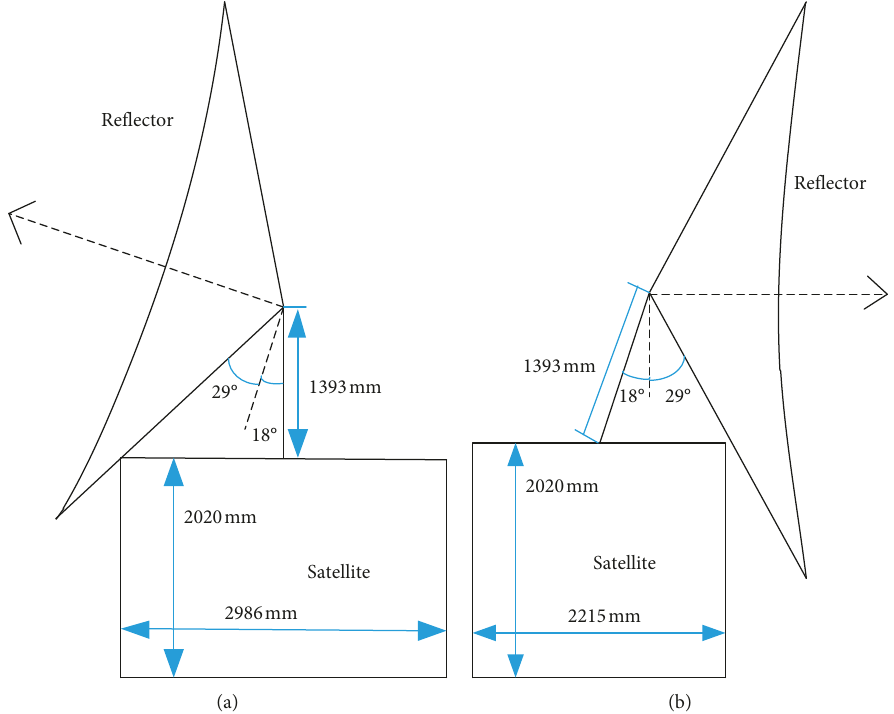
Figure 14: Size determination of the support structure: (a) status for power; (b) status for